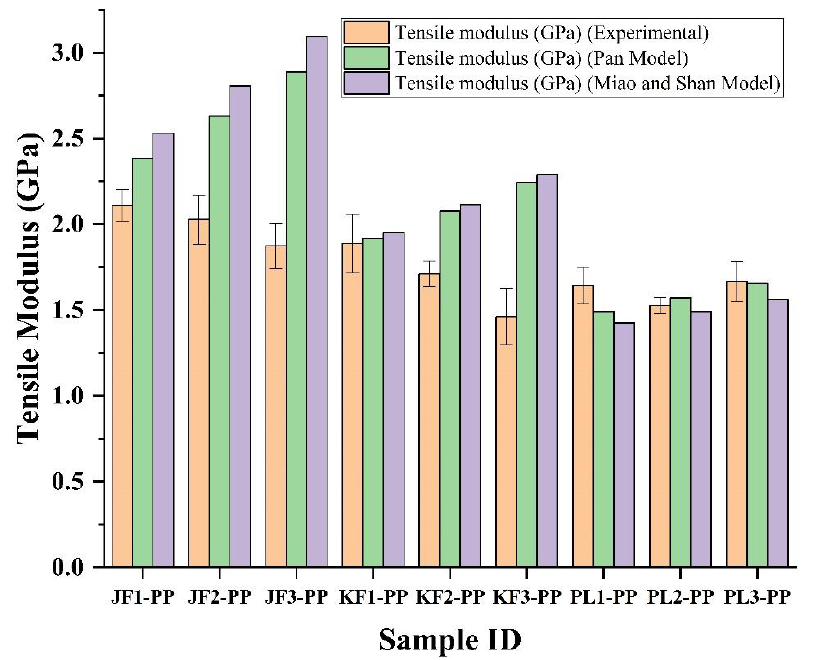
Figure 7. Comparison between theoretical and experimental results of elastic modulus of jute, kenaf, and PALF fibers-reinforced PP composites having different weight proportions of fibers.